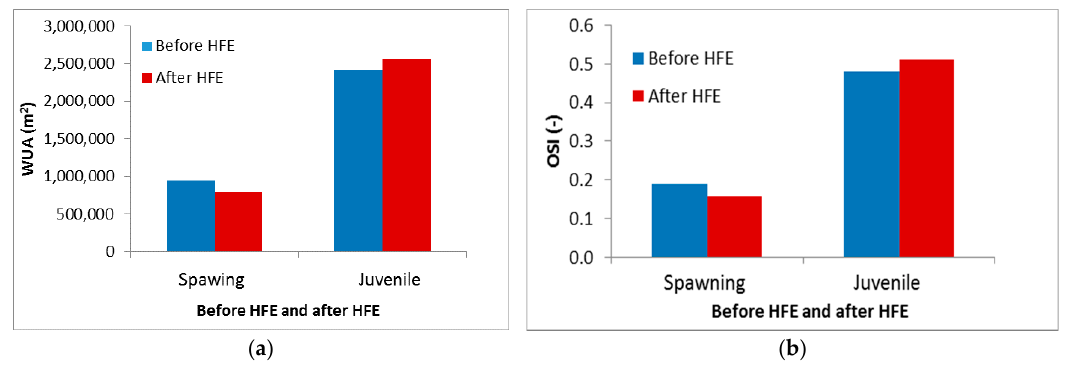
Figure 10. Before the HFE and after the HFE weighted usable areas ( WUA ) and overall suitability index ( OSI ) for spawning rainbow trout ( a ) and juvenile rainbow trout ( b ).